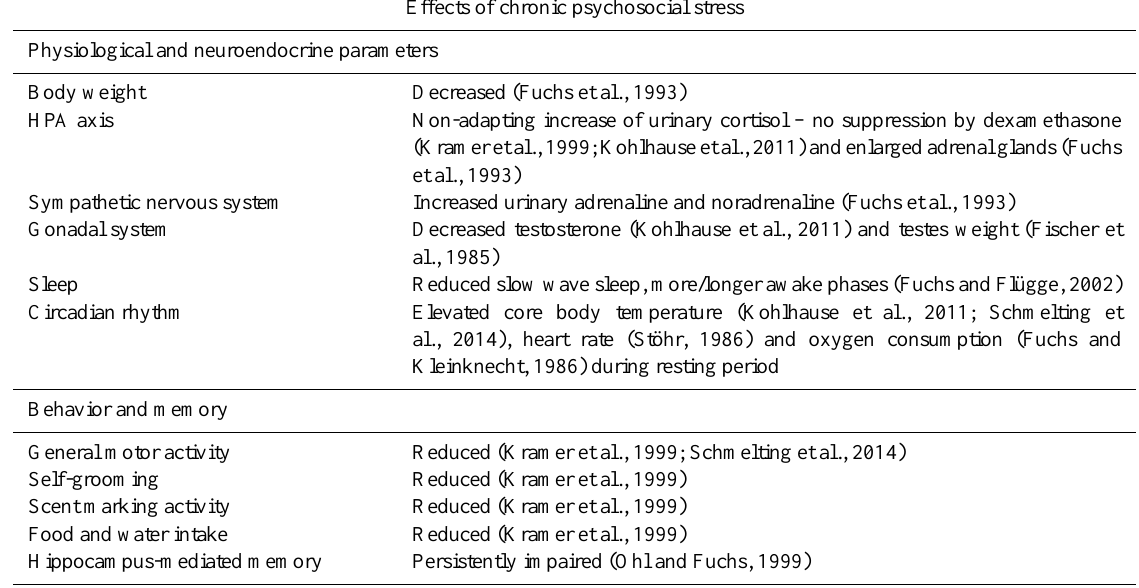
Table 1. Summary of stress-induced changes in male tree shrews. With modifications from Fuchs and Flügge